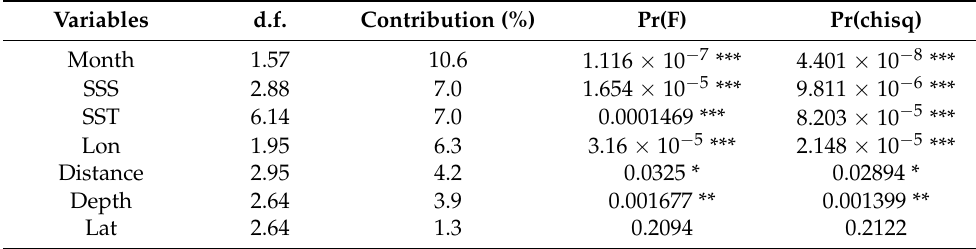
Table 4. Contributions of the selected variables in